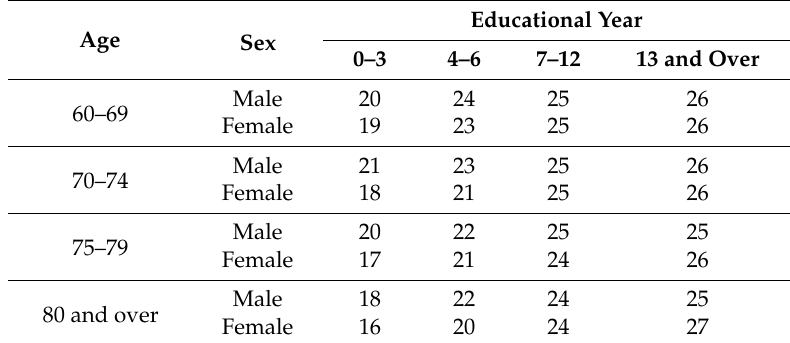
Table 1. Mini-Mental State Examination for Dementia Screening (MMSE-DS)